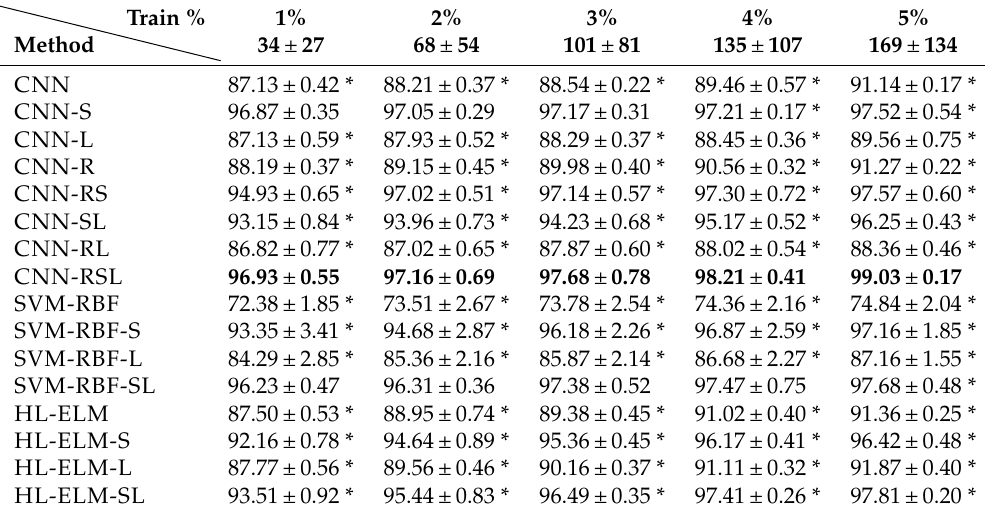
Table 7. Test set classification accuracy on the Salinas dataset when using 1–5% randomly sampled labeled pixels per class for training. We report the mean and standard deviation over 10 runs. We also list the mean and standard deviation of the number of training pixels per class for each training %. The best accuracy for each training set is indicated in bold. An ‘*’ means that the best accuracy is significantly better than the accuracy achieved by the corresponding method according to a binomial test for comparing classifiers [45] ( p -value < 0.05).